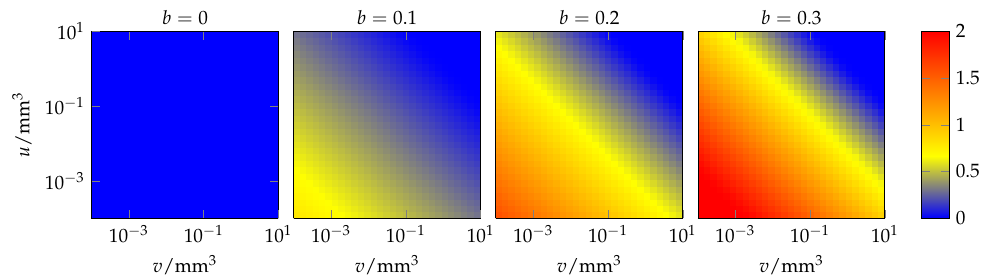
Figure 6. Agglomeration kernels β ( u , v ) for variations of b . Colors indicate rate of agglomeration for different volume combinations.